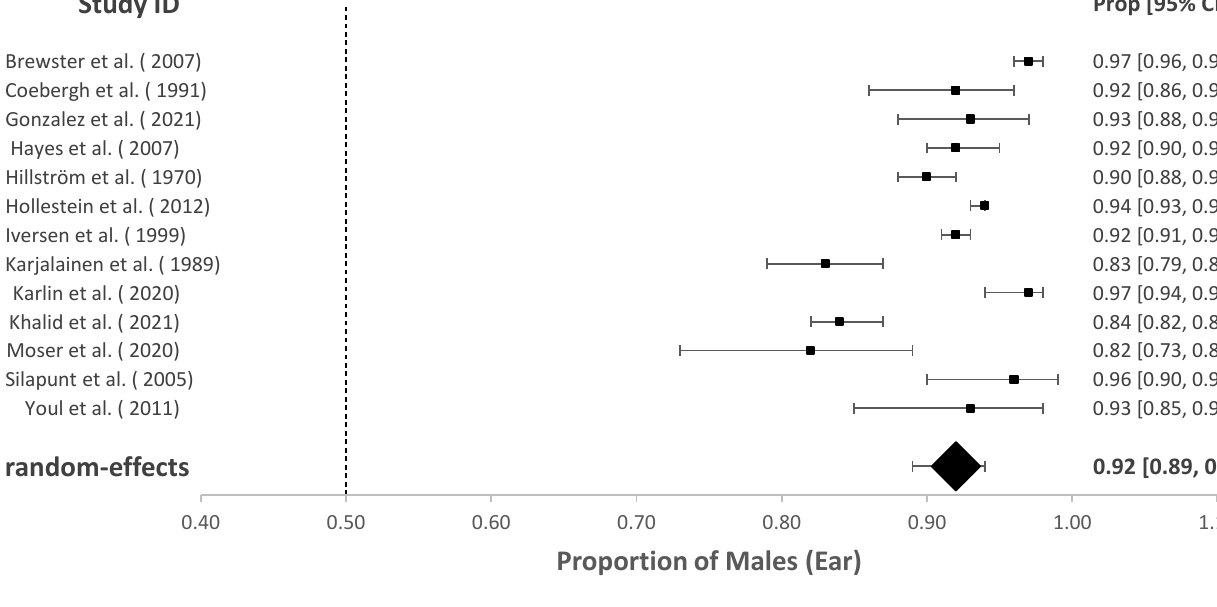
Figure 3. Proportion of males with cSCC of the ear [21,23,29,31,32,35,38,39,43,45,58,65,75].